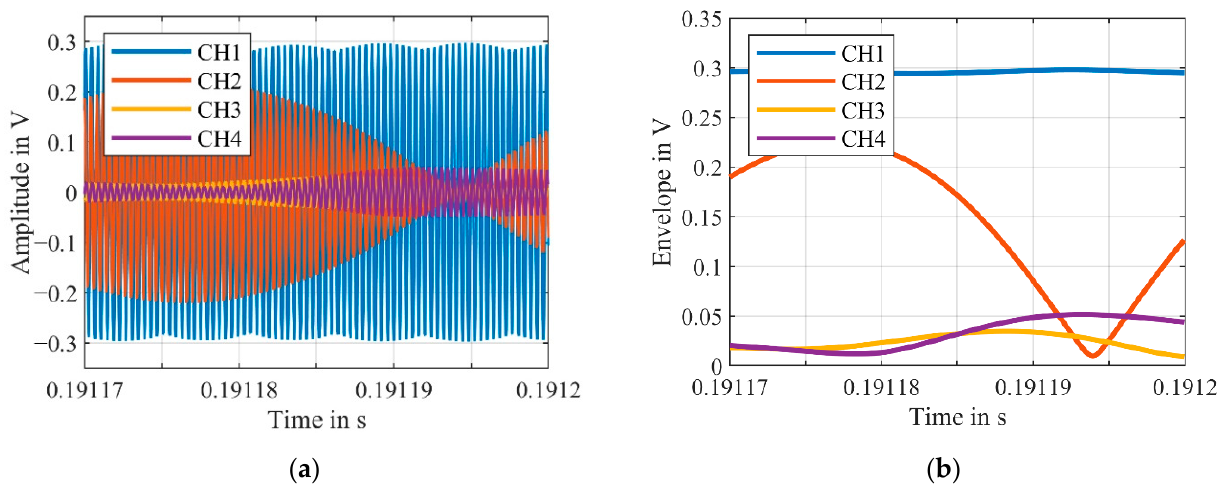
Figure 6. ( a ) Raw signals of the individual channels (CH1–CH4) at the same time segment as the velocity signals shown in Figure 5; ( b ) Upper signal envelope of the raw signals.